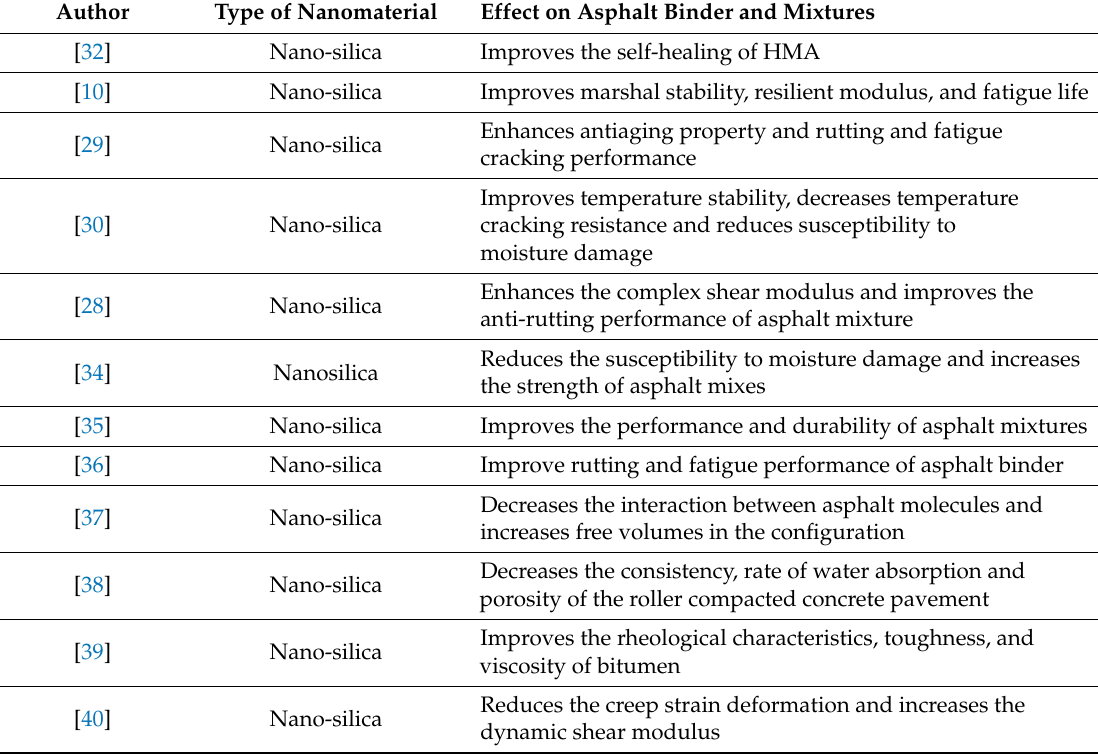
Table 1. Review of previous studies on modification of asphalt binder with